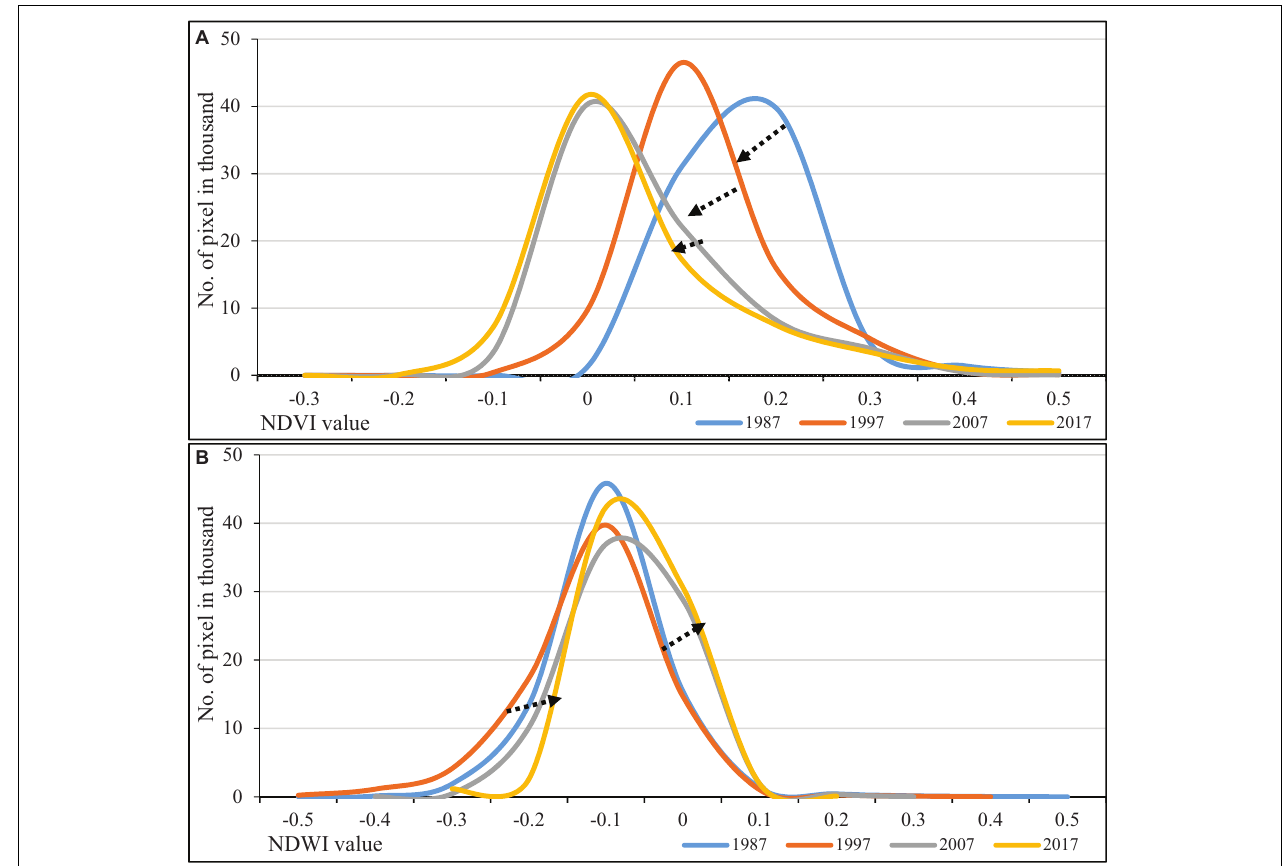
FIGURE 10 | Pixel identification of (A) NDVI and (B) NDWI, (1987, 1997, 2007, and 2017).